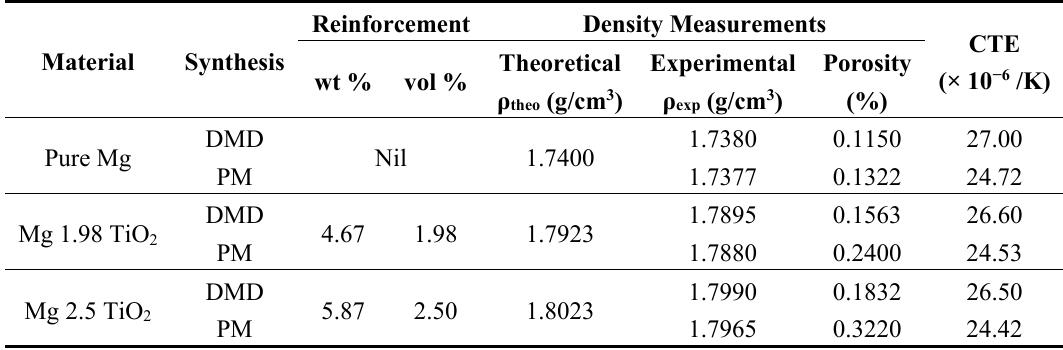
Table 1. Density and coefficient of thermal expansion values (CTE) measurements of pure magnesium and synthesized Mg-TiO 2